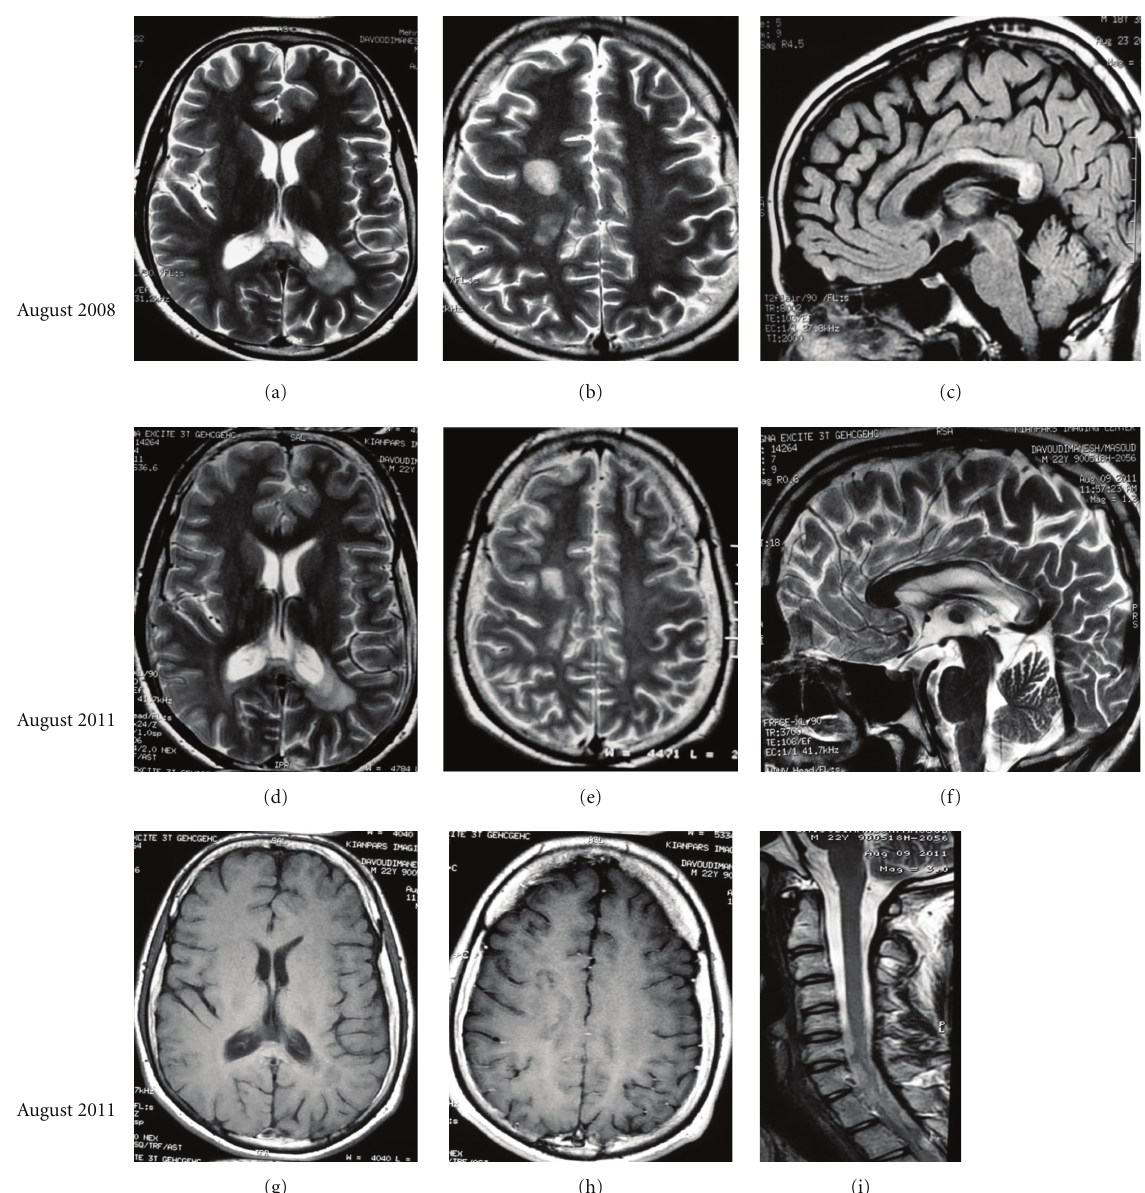
Figure 2: August 2008 (upper row): axial T2WI ((a) and (b)) and sagittal FLAIR (c) and August 2011 (middle row) axial T2WI ((d), (e), and (f)) demonstrate sequelae of lesions as multifocal high T2 signal intensities in right centrum semiovale area and peri-left-occipital horn white matter, involving also splenium and posterior body of the corpus callosum which were stable and the peripheral vasogenic edema is gone. August 2011 (lower row) postcontrast axial T1 W images ((g) and (h)) and sagittal cervical spine T2 WI (i), no enhancement in lesion or abnormal signal intensity in cervical cord were